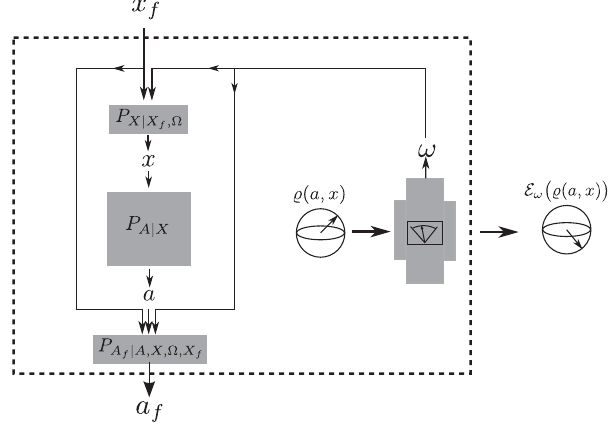
FIG. 1. Schematic representation of a 1W-LOCC map M : The initial assemblage ρ A consists of a black box, with inputs x and j X , in Alice ’ s outputs a , governed by the probability distribution P A j X hand, and a quantum subsystem in one of the states f ϱ ð a; x Þg a;x , in Bob ’ s hands. The final assemblage ρ A ¼ M ð ρ A Þ is given j X f j X f by a final black box, represented by the dashed-lined rectangle, of inputs x f and outputs a f , and a final subsystem, outside the dashed-lined rectangle, in the state ϱ ð a f ; x f Þ ¼ E ω ( ϱ ð a; x Þ ) . To implement M , first Bob applies, with a probability P Ω ð ω Þ , a stochastic quantum operation E ω that leaves his subsystem in the state E ω ( ϱ ð a; x Þ ) . He communicates ω to Alice. Then, Alice generates x by processing the classical bits ω and x f with a local wiring described by a conditional distribution P X . She j X f ; Ω inputs x to her initial device, upon which the bit a is produced. Finally, Alice generates the output a f of the final device by processing x f , ω , x , and a , with a local wiring described by a distribution P A f j A;X; Ω ;X f